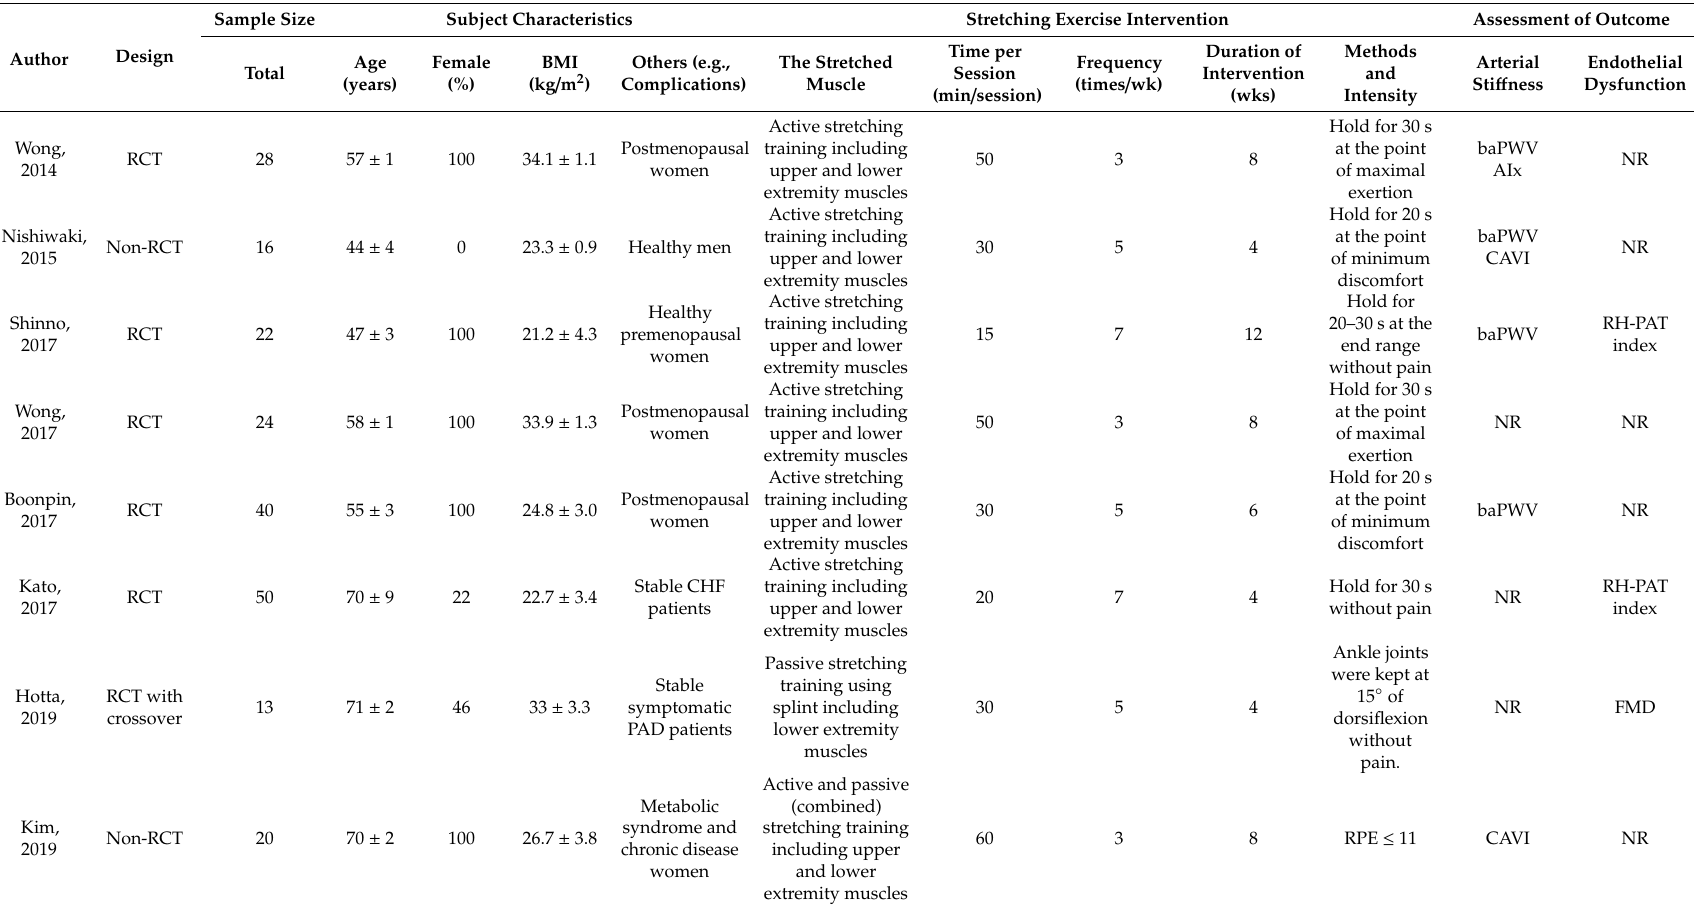
Table 1. Characteristics of included